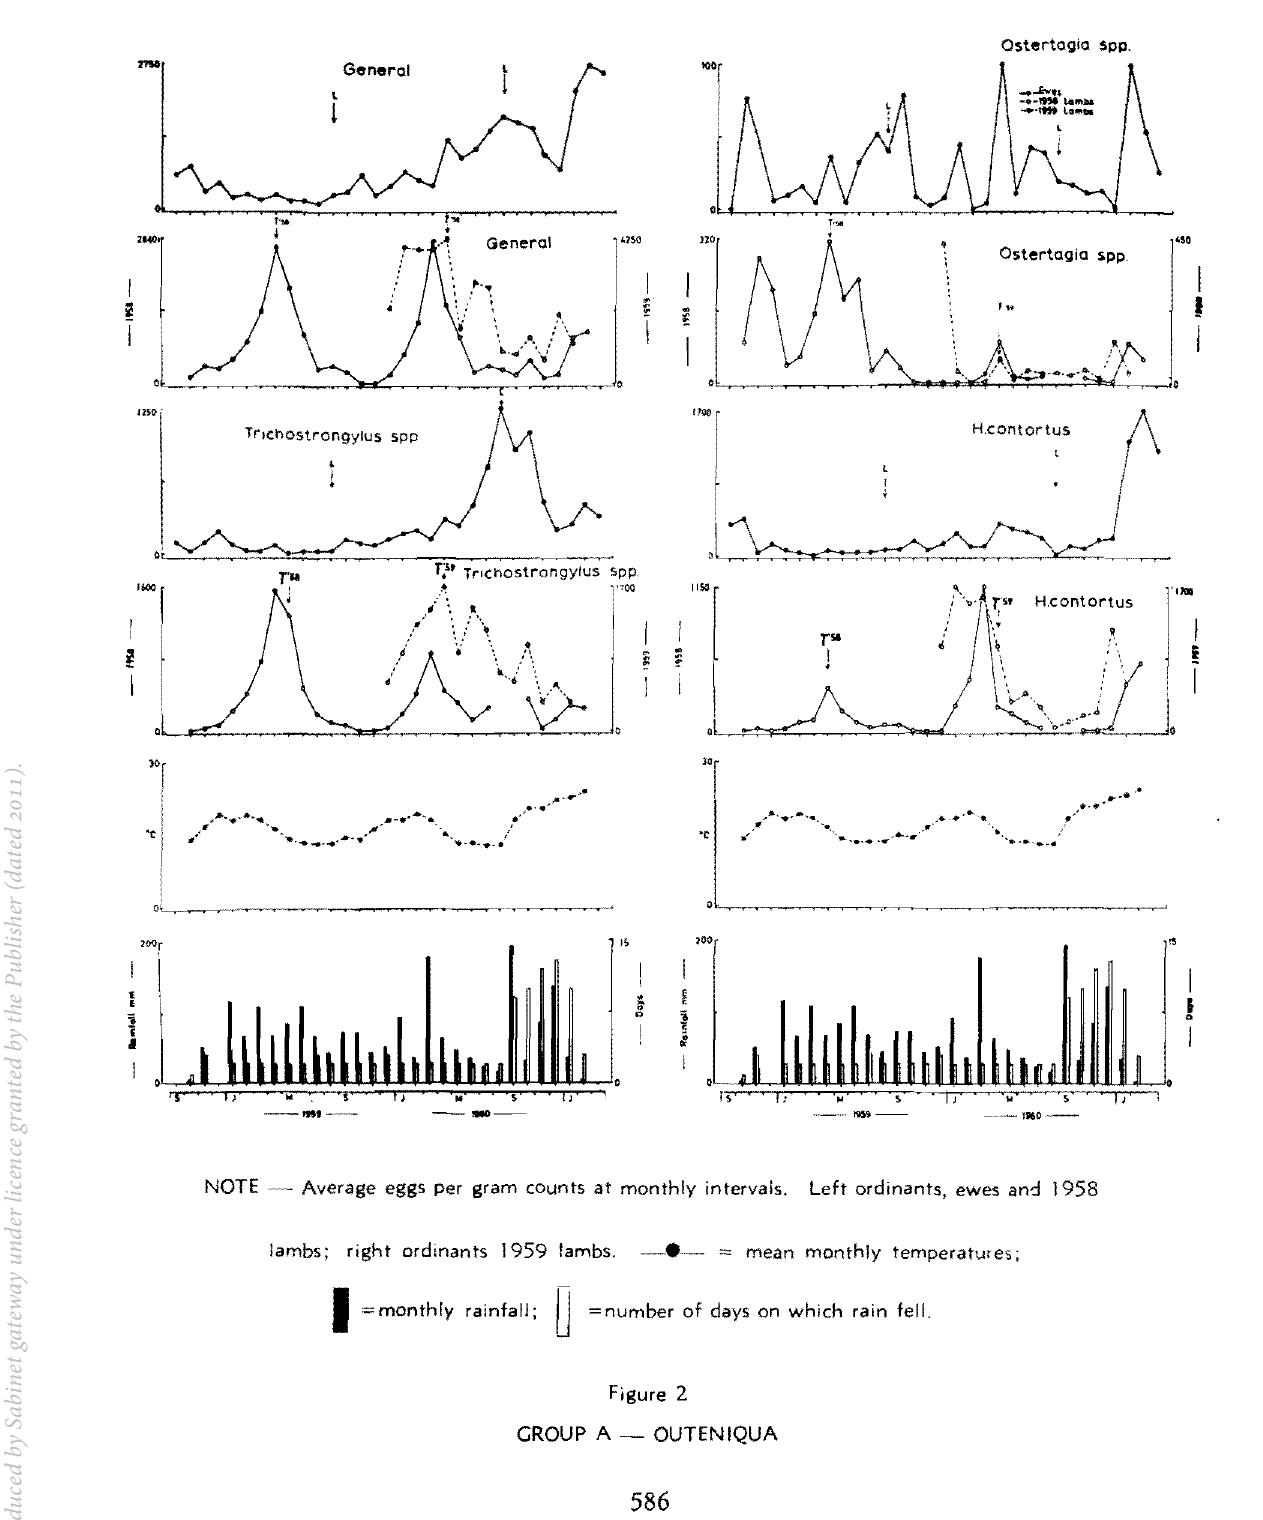
Figure 2 GROUP A - OUTENIQUA